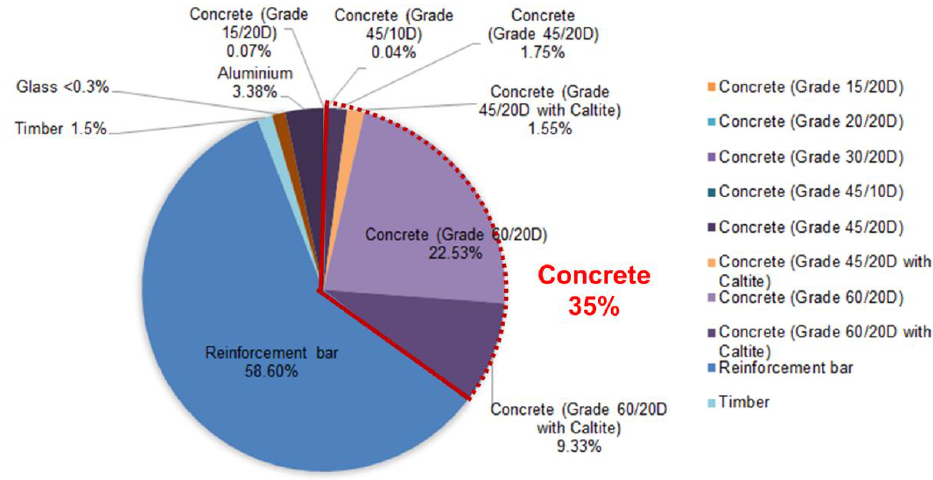
Figure 1. Breakdown of upfront carbon emissions for construction materials. Table 3. Quantitative comparison of cradle-to-site carbon